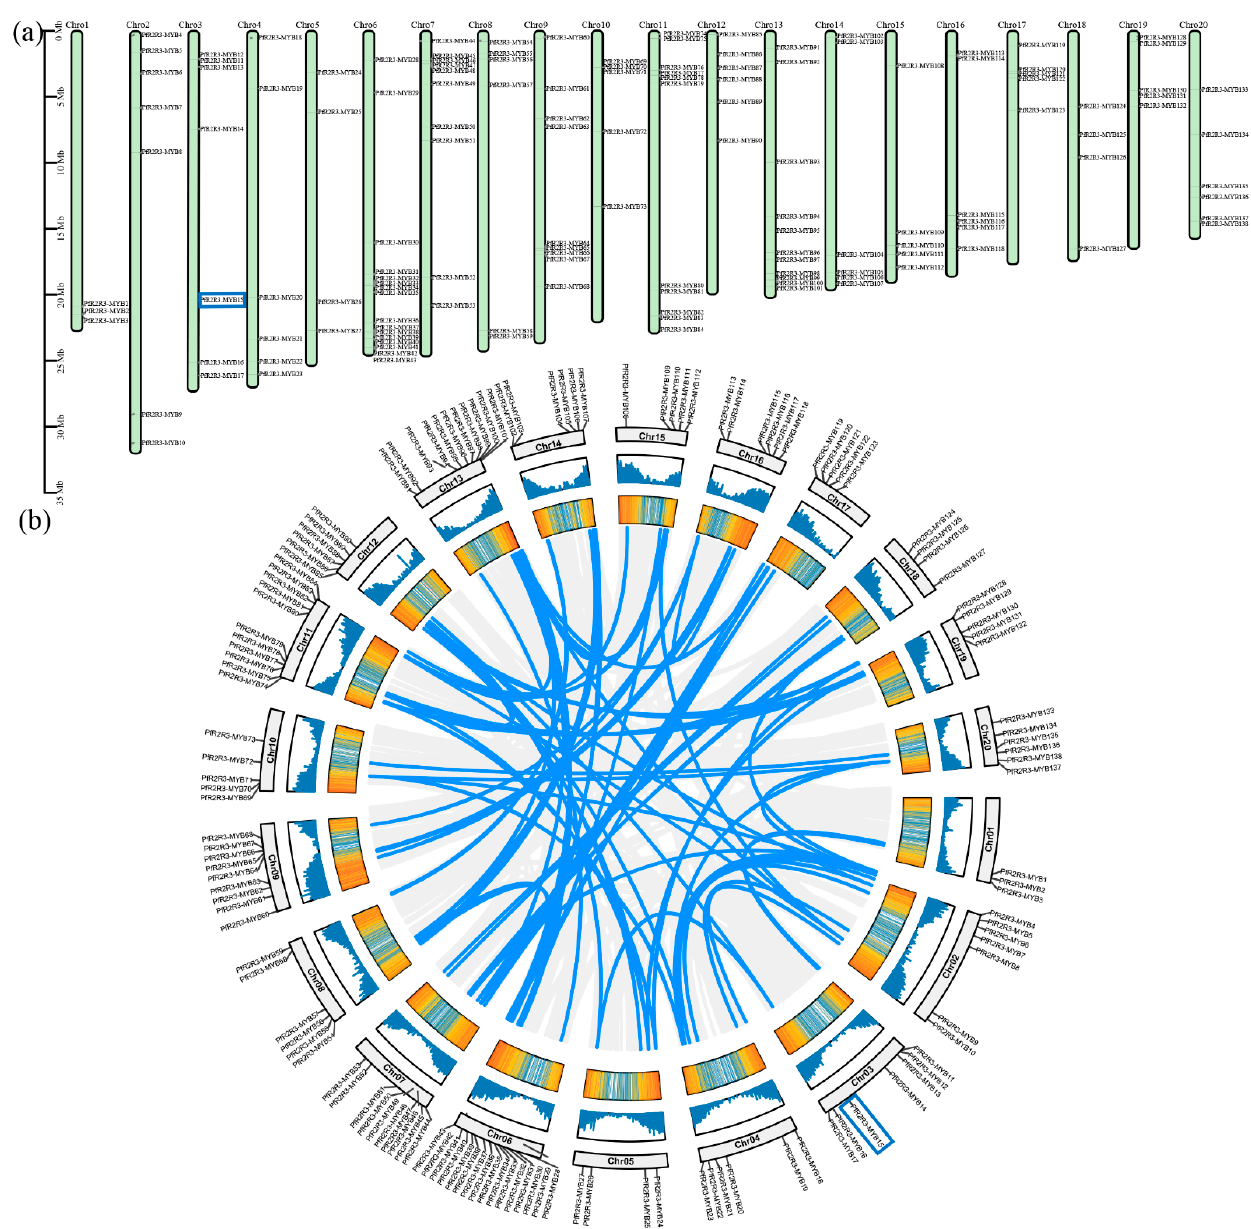
Figure 1. Localization and collinearity analysis of PfR2R3-MYBs . ( a ) 138 PfR2R3-MYB genes were randomly distributed on P. fortunei chromosomes. ( b ) The duplicated PfR2R3-MYB gene relationship. The blue line represents the gene pair of PfR2R3-MYB .